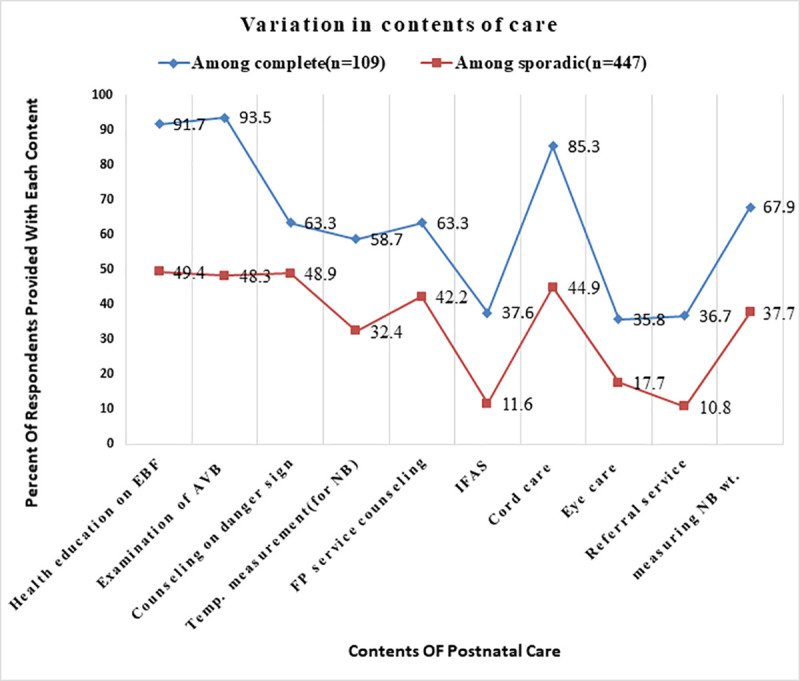
Variation in the receipt of contents of care among study participants with complete versus sporadic PNC, in Ezha district, Southern Ethiopia, February 10-March 10, 2019.